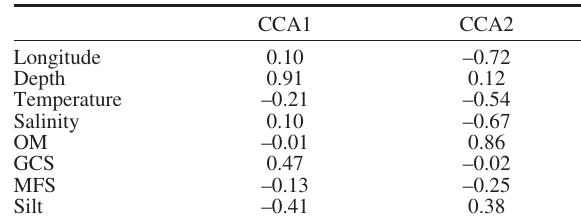
Table 2. – Canonical coefficients for each environmental variable on each canonical axis (CCA) on the aggregations of F. quadran- gularis and Pennatula spp. GCS, weight percentage of gravel and coarse sands (>500 µm); MFS, weight percentage of medium, fine and very fine sands (63-500 µm); Silt, percentage weight of silt (<63 µm); OM, weight percentage of organic